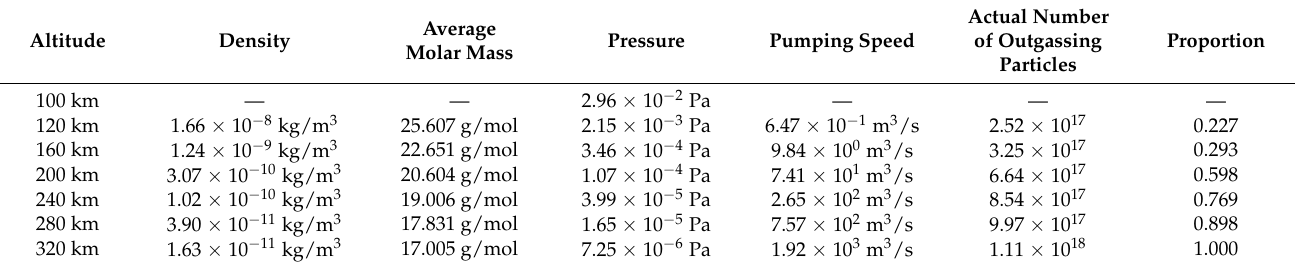
Table 10. Data related to outgassing at different altitudes under the ML case.